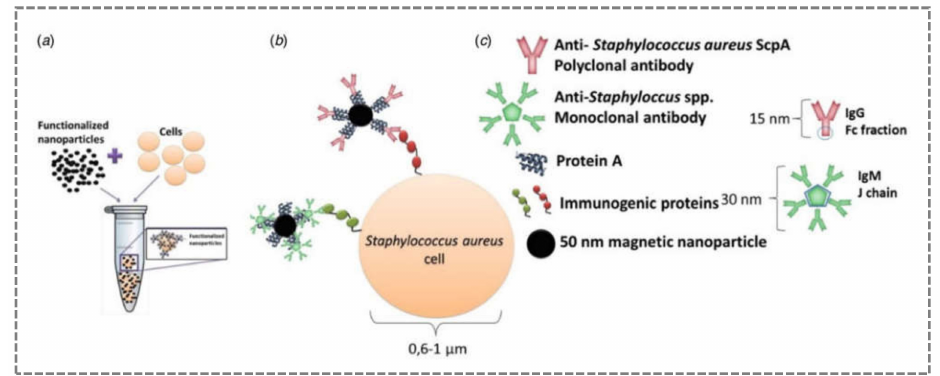
Figure 5. Scheme representing the immunomagnetic detection of cells: functionalised MNPs are incubated with bacterial cells ( a ), biological affinities between MNPs functionalised with different antibodies and bacterial cell wall immunogenic proteins ( b ), and predictable protein A binding site to each antibody ( c ) (reproduced with permission from Duarte et al. (2017) [67], Copyright 2017, Cambridge University